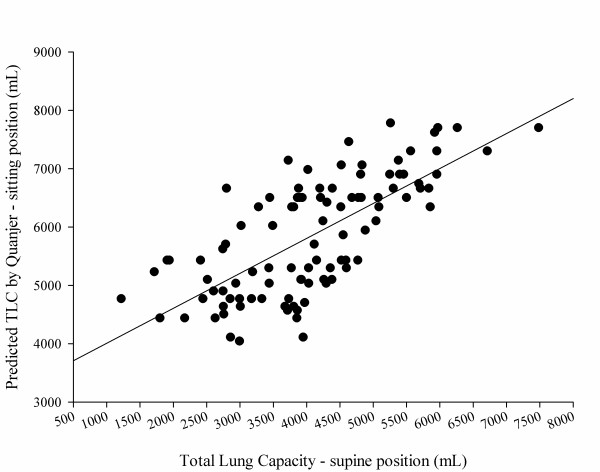
Total lung capacity in a sitting position predicted according to Quanjer and colleagues [9,12]. Total lung capacity (TLC) measured in a supine position as a function of computed tomography (CT) scan. (A) According to Quanjer and colleagues [9,12]: TLC (ml) (sitting) = 3,409 + 0.60 × CT scan (supine). P <0.0001, r2 = 0.50. (B) Bland-Altman plot of the previous correlation. The average difference between the TLC predicted by Quanjer and colleagues [9,12] (sitting) and the CT scan TLC (supine) was 1,779 ± 849 ml (930 to 2,628). The difference between the predicted sitting TLC and the measured supine TLC decreased with the total gas volume increase. The difference between predicted TLC (Quanjer and colleagues) and measured TLC = 2,770 - 0.20 × (predicted TLC + measured TLC) / 2. P <0.001, r2 = 0.05.